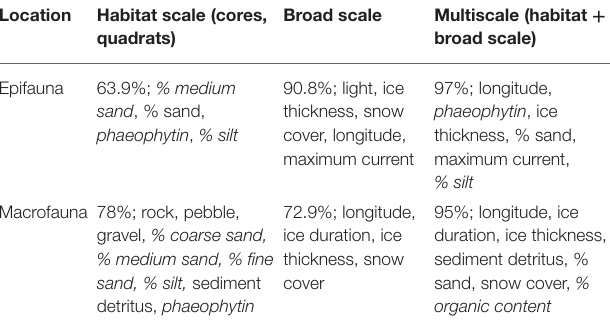
TABLE 6 | Summary of results of the Canonical Correspondence Analysis (CCA) conducted to link benthic community composition to habitat scale and broad scale characteristics, separately and together